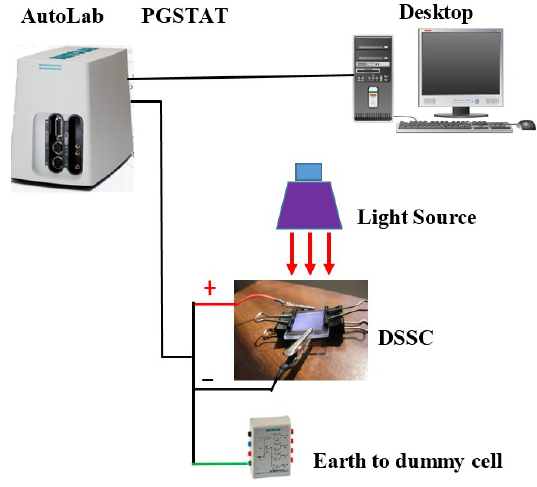
Figure 3. Electrical characterization setup using AutoLab PGSTAT204 system.